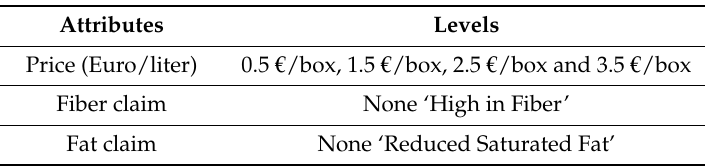
Table 1. Breakfast biscuits attributes and